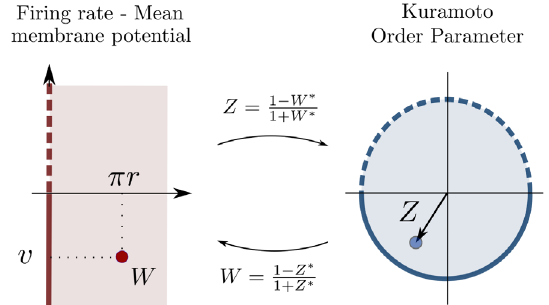
FIG. 4. The conformal map Eq. (18) transforms the right half- plane onto the unit disk. This transformation and its inverse define a one-to-one mapping between the Kuramoto order parameter Z and the macroscopic quantities of the population of QIF neurons: r , firing rate; v , mean membrane potential. Note that in the limit Z ¼ e i Ψ [full coherence, ~ ρ ð θ Þ ¼ δ ð θ − Ψ Þ ], we recover v ¼ i ð 1 − e i Ψ Þ = ð 1 þ e i Ψ Þ ¼ tan ð Ψ = 2 Þ , as the original mapping V ¼ tan ð θ = 2 Þ between QIF and theta neurons